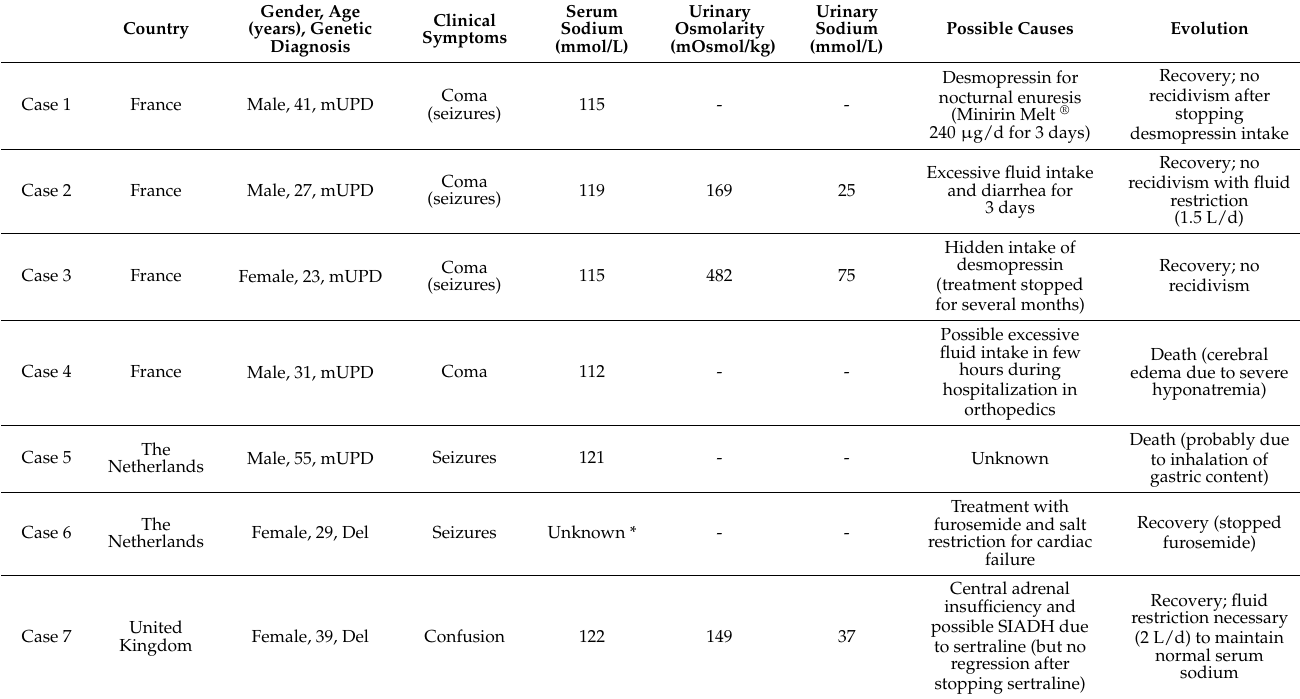
Table 1. Description of severe cases of hyponatremia in adults with Prader–Willi syndrome from three countries, possible causes and evolution.